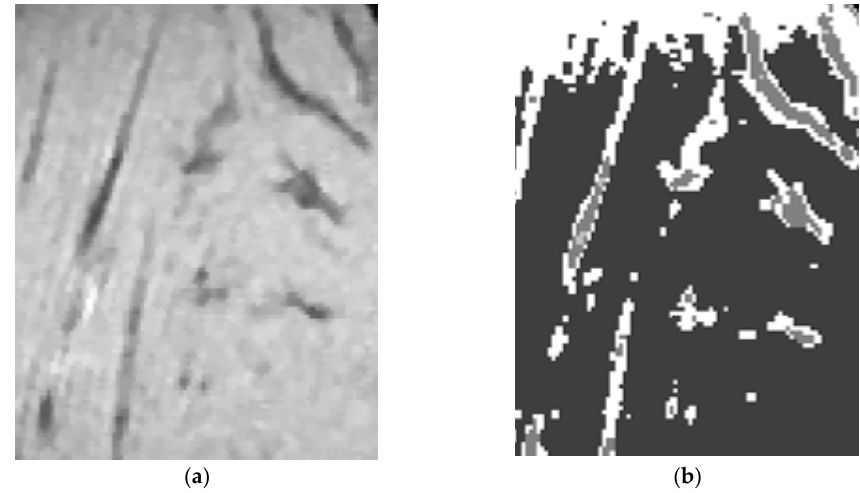
Figure 2. Pre-processing: ( a ) original image, ( b ) pre-processing image.